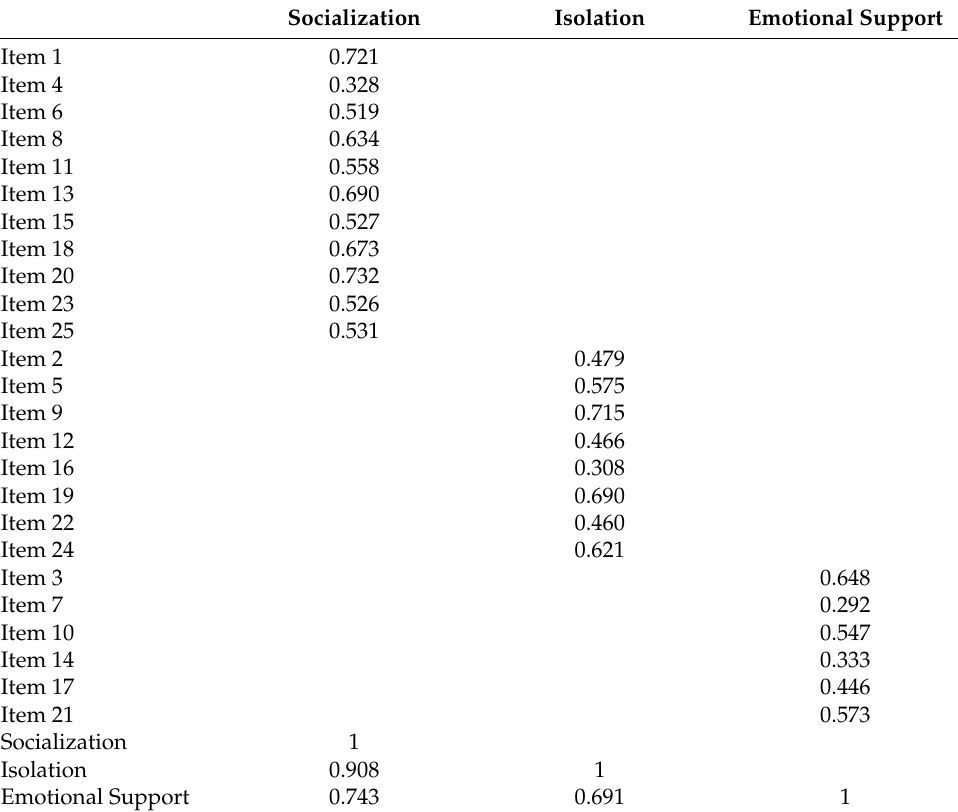
Table 1. Completely standardized factor loadings among and latent correlations between the three factors of the